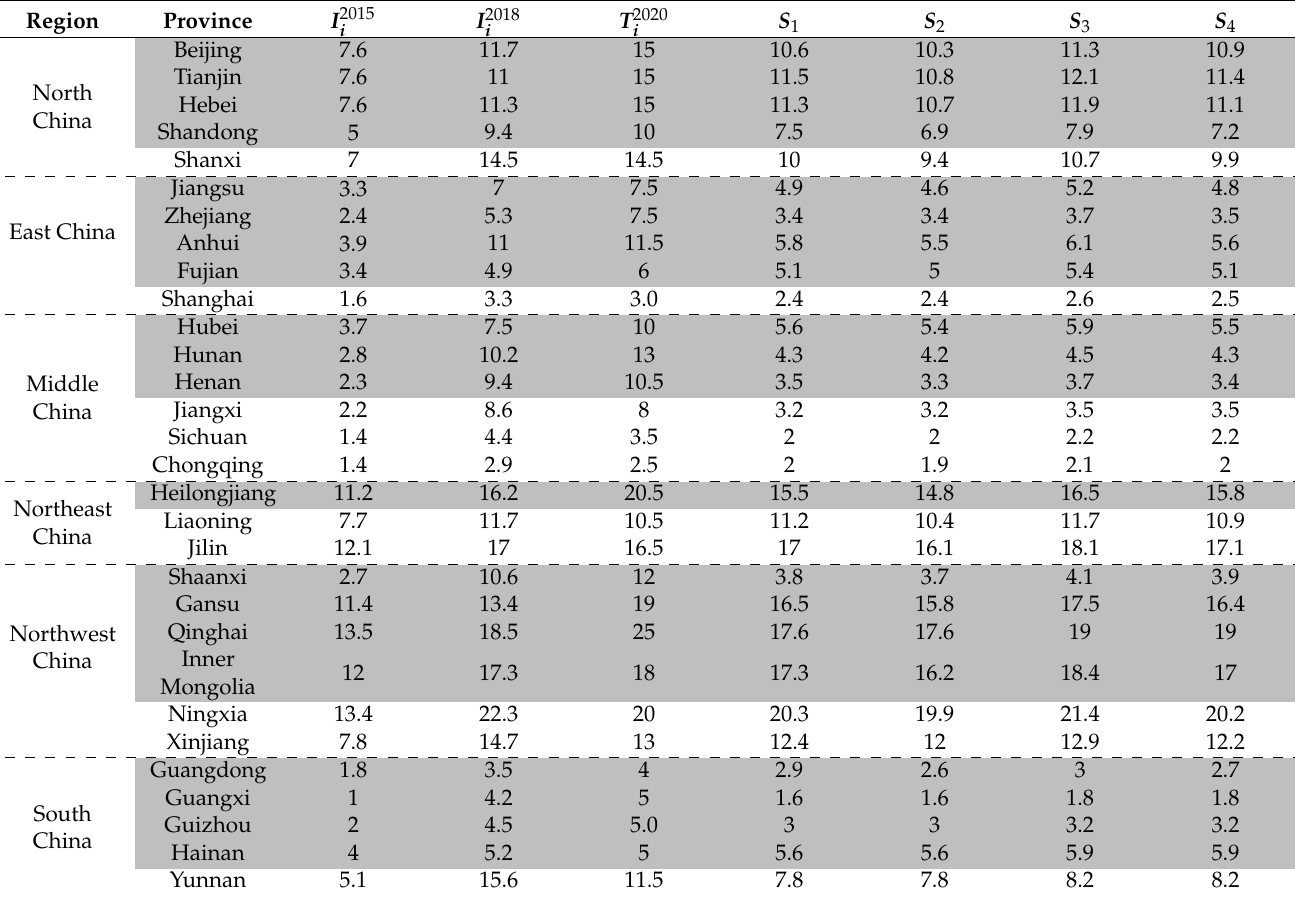
Table 5. Simulation results for the index of RPS completion by single approach of flexibility modification 1,2 .